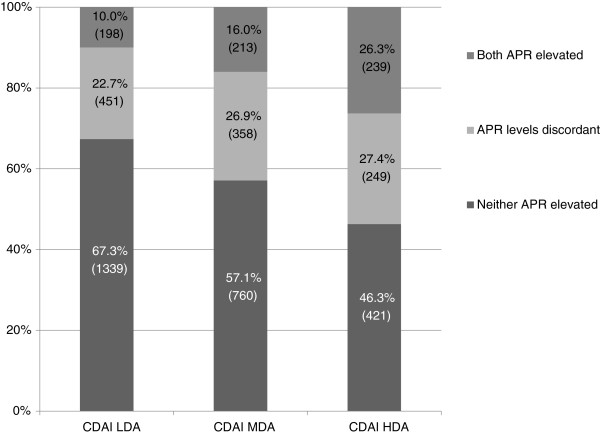
Distribution of acute phase reactant groups among the CDAI disease activity levels at baseline. Distribution of acute phase reactant groups among the CDAI disease activity levels at baseline in the 4,228 RA patients with a one-year follow-up visit. Percentages within the bars indicate relative proportions of subjects within each CDAI disease activity level. Numbers in parentheses within the bars enumerate subjects in each group. CDAI, Clinical Disease Activity Index; RA, rheumatoid arthritis; LDA, low disease activity; MDA, moderate disease activity; HDA, high disease activity.